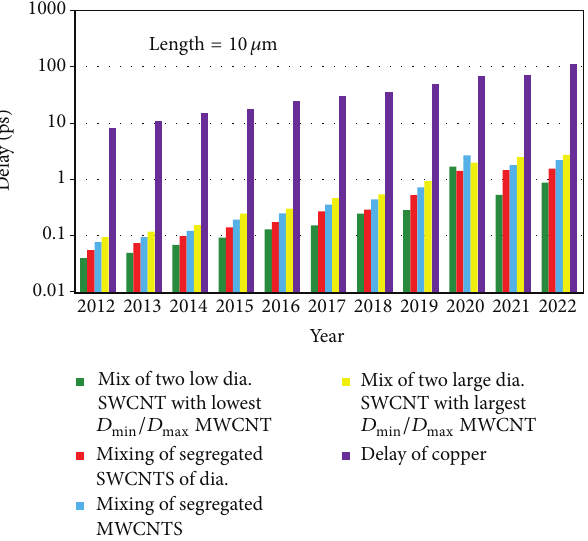
Figure 5: Propagation delay of mixed CNT bundle versus segre- gated bundle at semiglobal